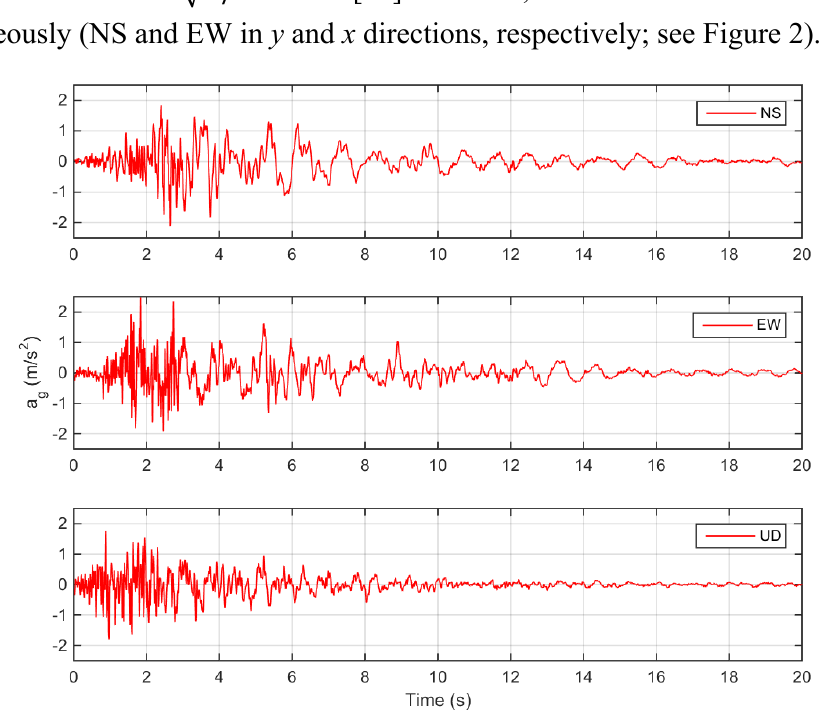
Figure 4. Colfiorito north-south (NS), east-west (EW) and up-down (UD) ground acceleration time